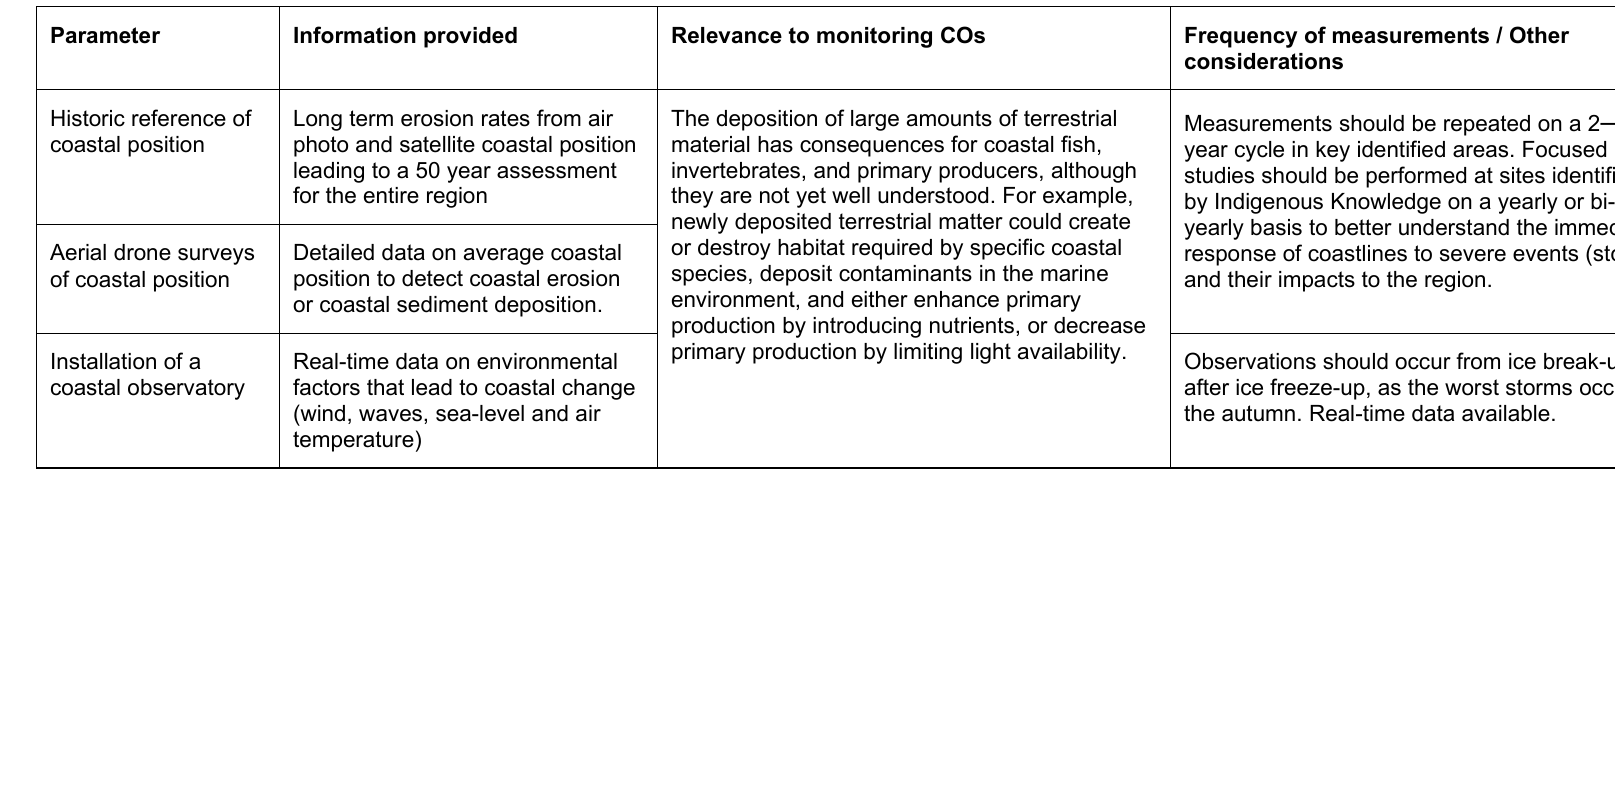
Table C4. Key measurement parameters for monitoring coastal change (Section